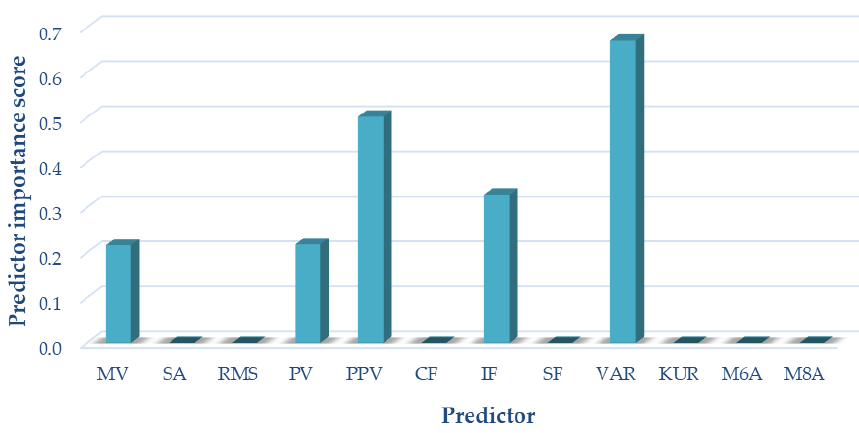
Figure 6. Selection of optimal features for variant I (OKC).